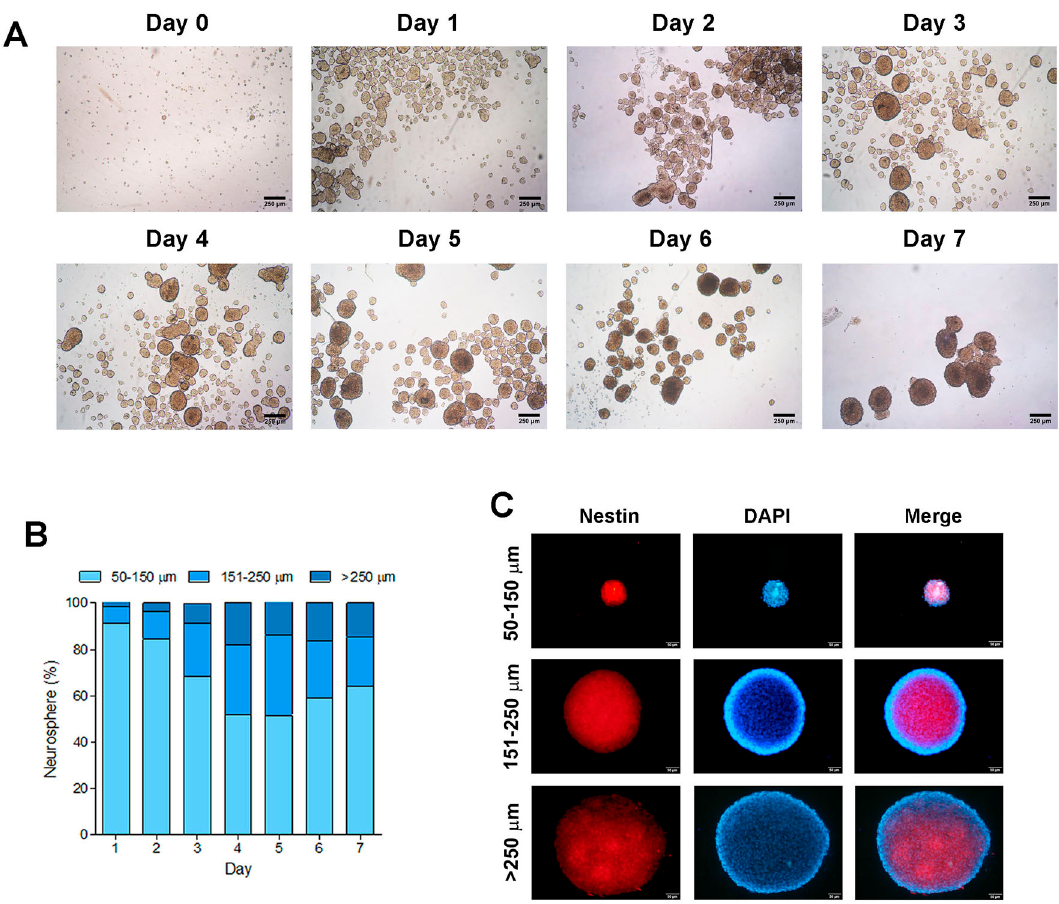
Figure 3- Optimal time for culturing neurospheres. (A) Neurospheres culture from day 0 to day 7. (B) Percentage of each size of the neurospheres on each day of the culture. (C) Immunofluorescence images of representative neurospheres in 50-150 µm, 151-250 µm, and >250 µm of diameter showing the expression of Nestin (red). The nuclei were counterstained with DAPI